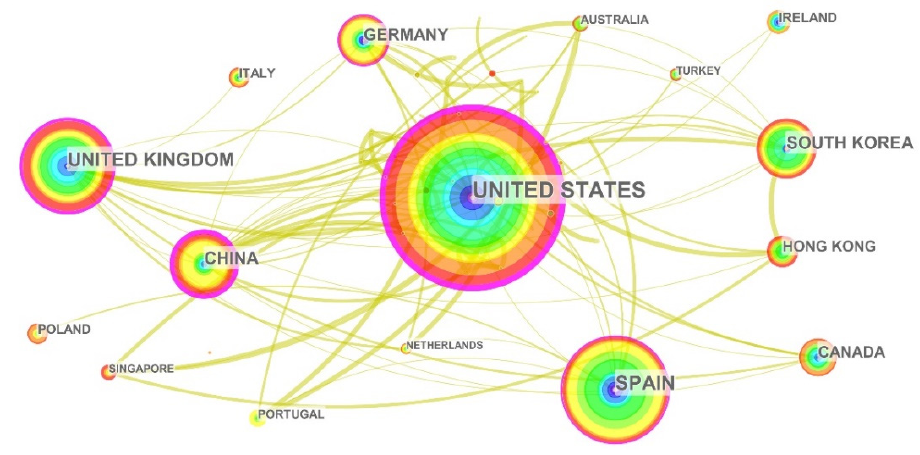
Figure 5. Network of countries/regions.